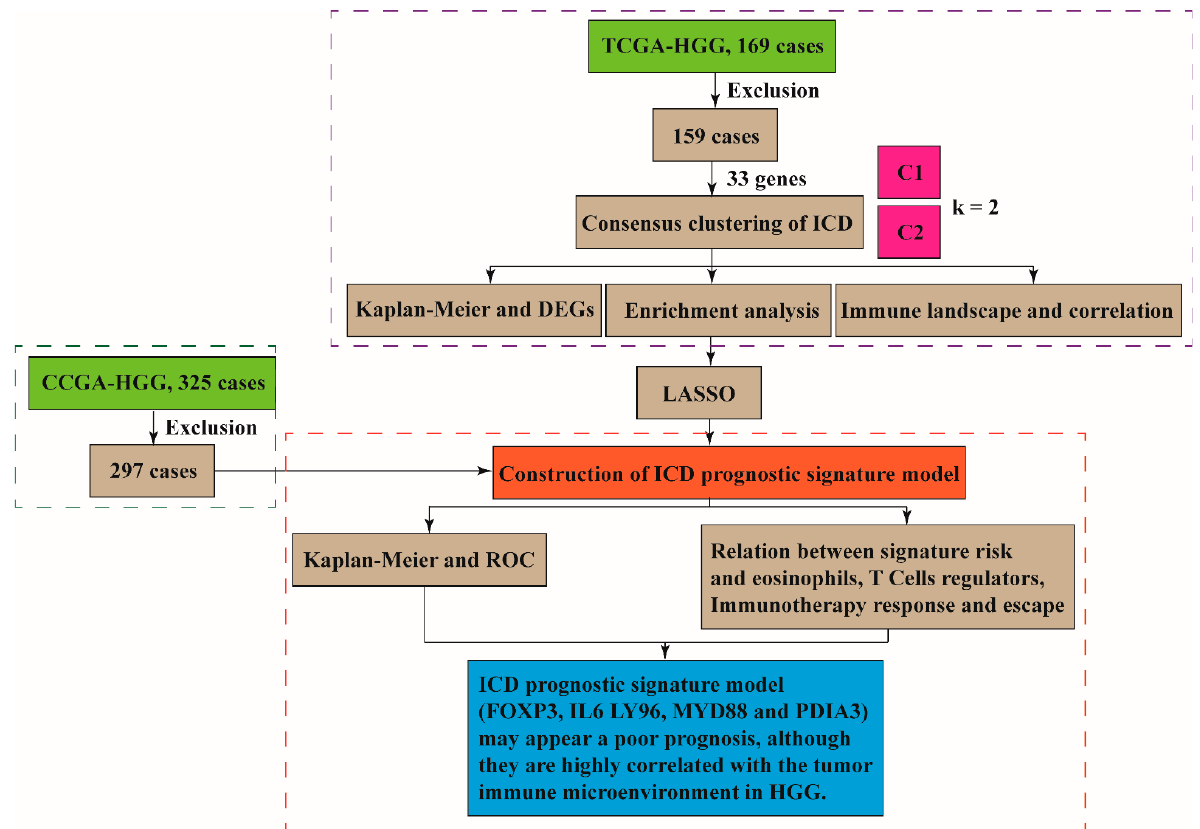
Figure 1. The workflow of the study.